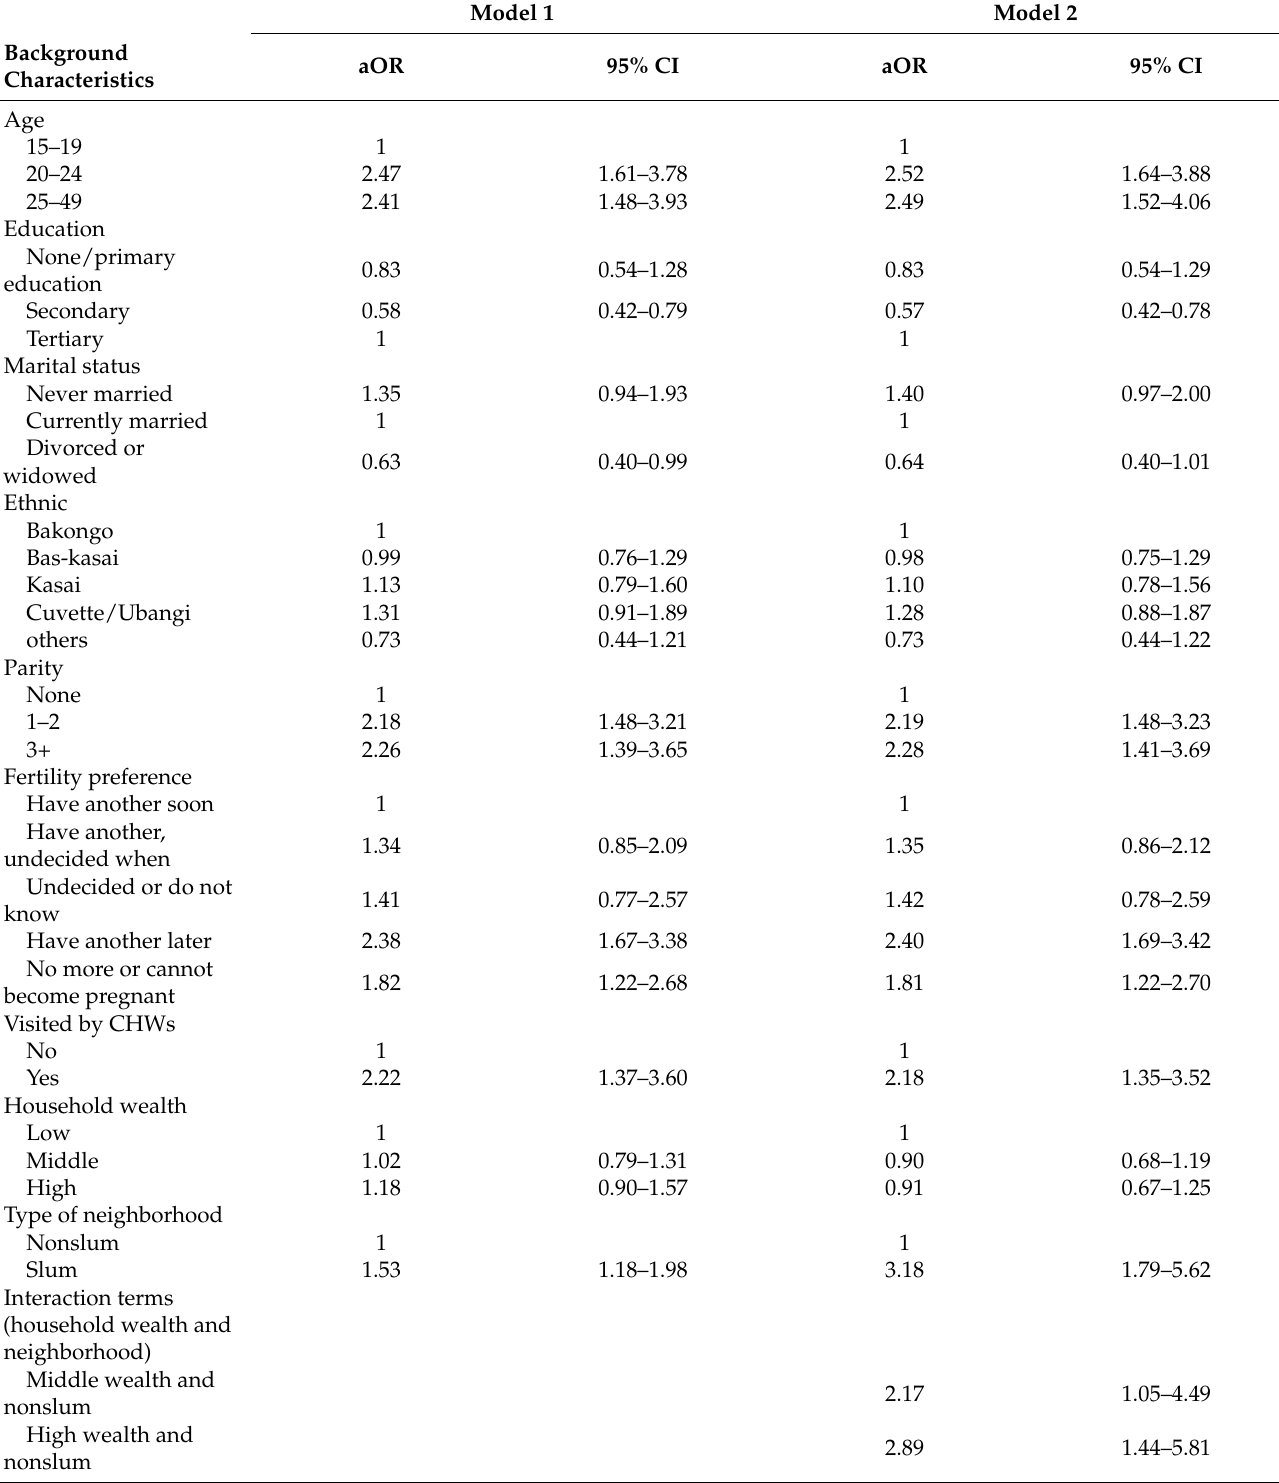
Table 4. Results of logistic-regression models of modern contraceptive use among women aged 15–49, Kinshasa,